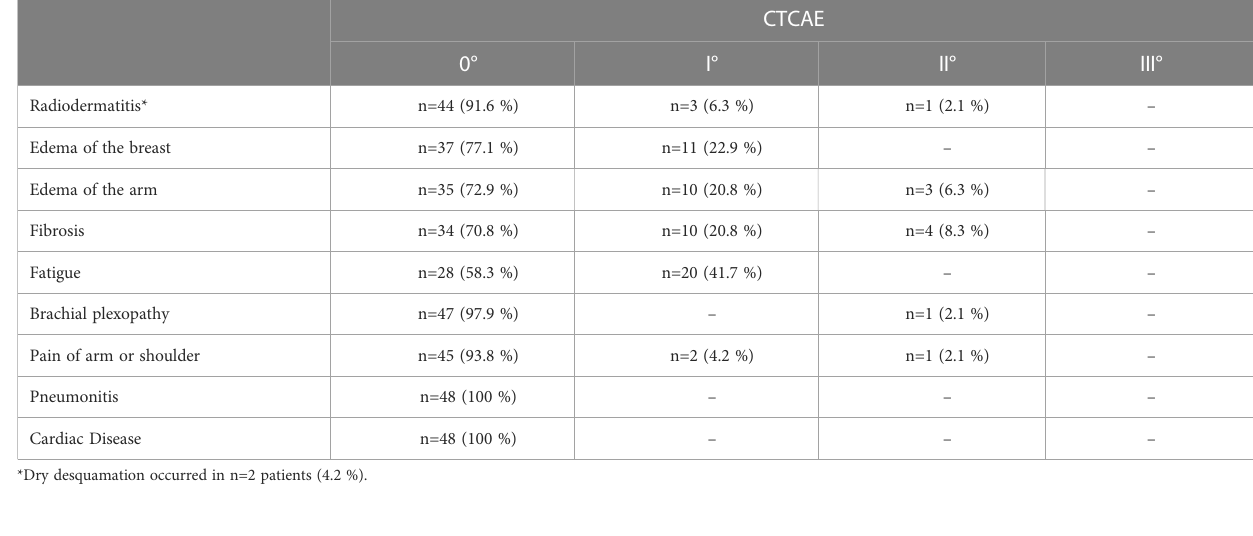
TABLE 2 Summary of late effects (absolute and relative numbers) classi fi ed by